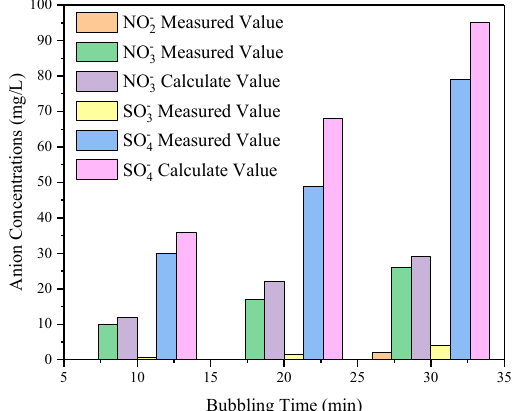
Figure 7. Product analysis for desulfurization and denitrification ([NO], 300 ppm; [SO 2 ], 1000 ppm; n / n , 1.2; inlet gas temperatures 200 °C; artificial seawater, 30 L).